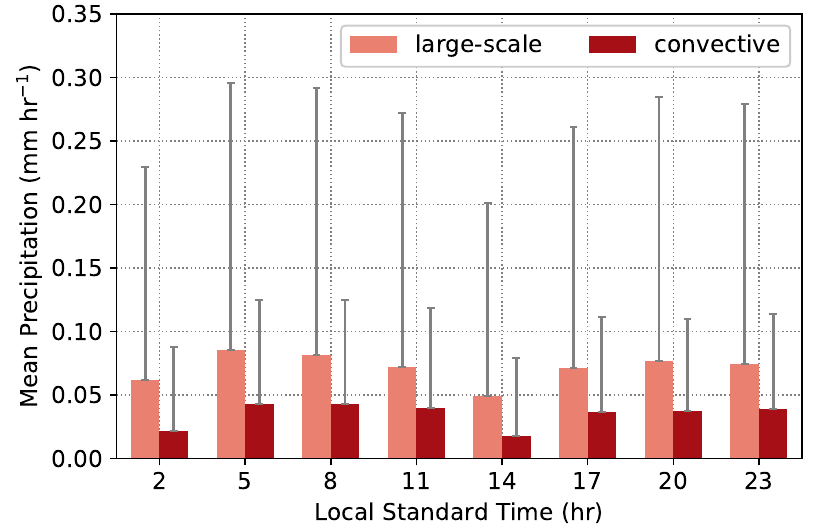
Figure 3. Diurnal cycle of ERA-Interim components’ large scale and convective precipitation. Error bars show one standard deviation.